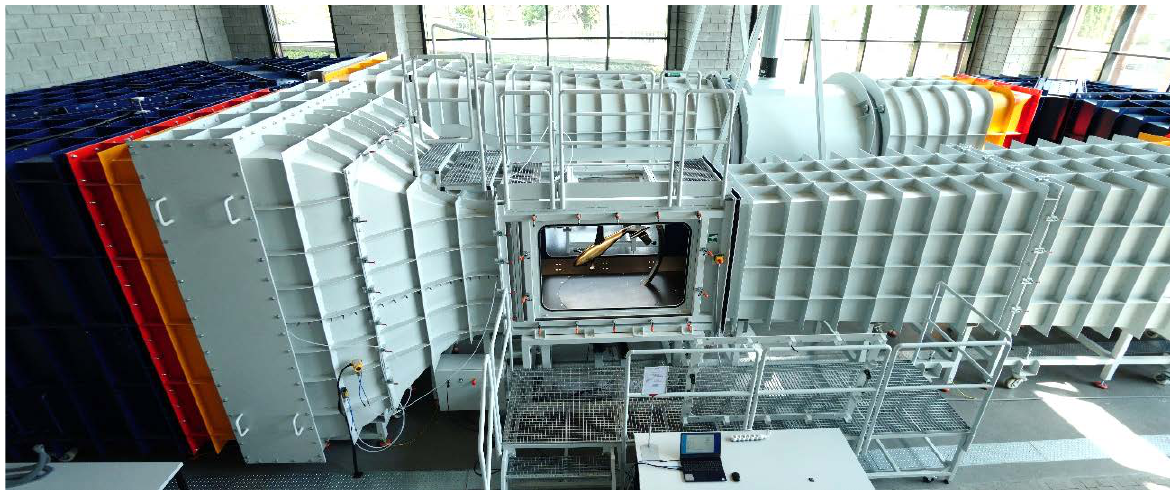
Figure 2. General view of the wind tunnel.